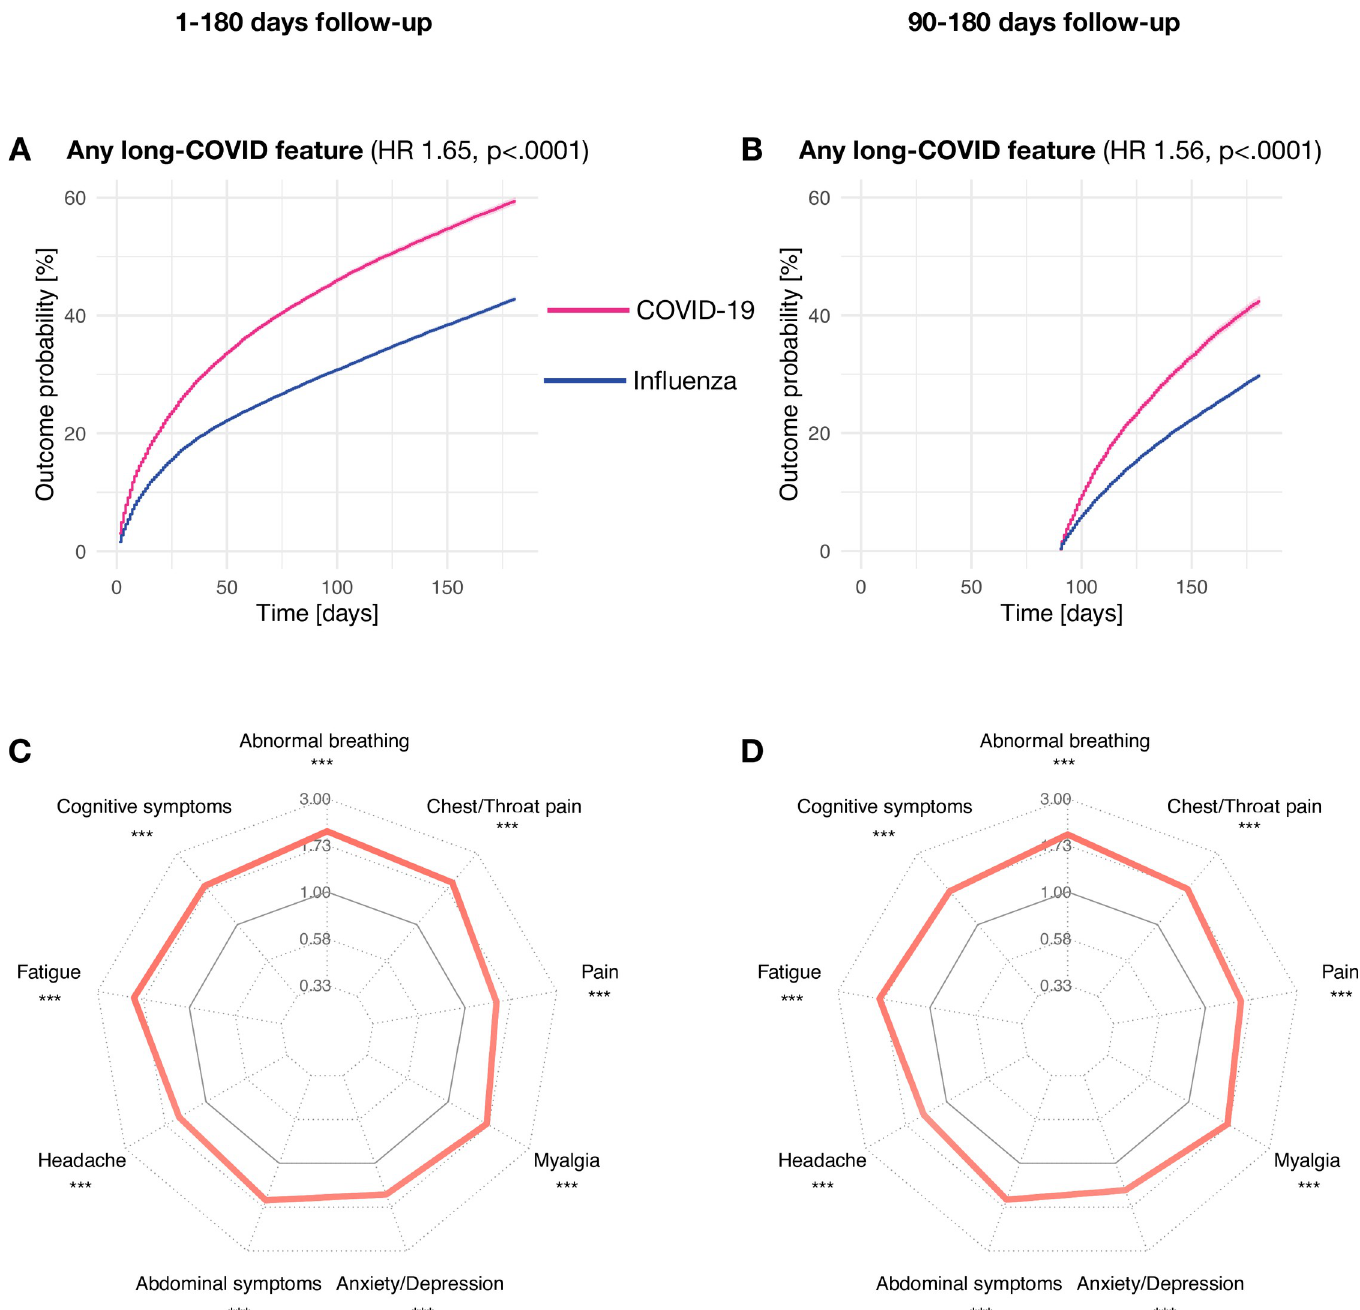
Fig 2. (A, B) Kaplan–Meier curves showing the emergence of long-COVID features over 6 months (A) and specifically over the “long” phase from 3 to 6 months (B) in the cohorts of patients diagnosed with COVID-19 and the matched cohort of patients diagnosed with influenza. (C, D) HRs of individual long-COVID features comparing the cohort of patients with COVID-19 to the matched cohort of patients with influenza. � p < 0.05, �� p < 0.01, ��� p < 0.001. All long-COVID features are more common after COVID-19 than after influenza. For Kaplan–Meier curves of individual long-COVID features, see Fig A in S1 Fig. COVID-19, Coronavirus Disease 2019; HR, hazard